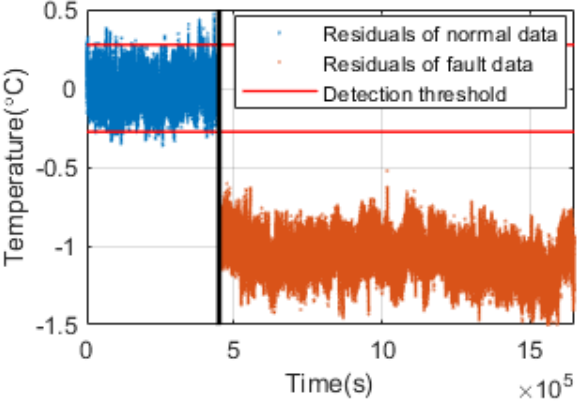
Figure 19. Corresponding residuals in fault early warning set.